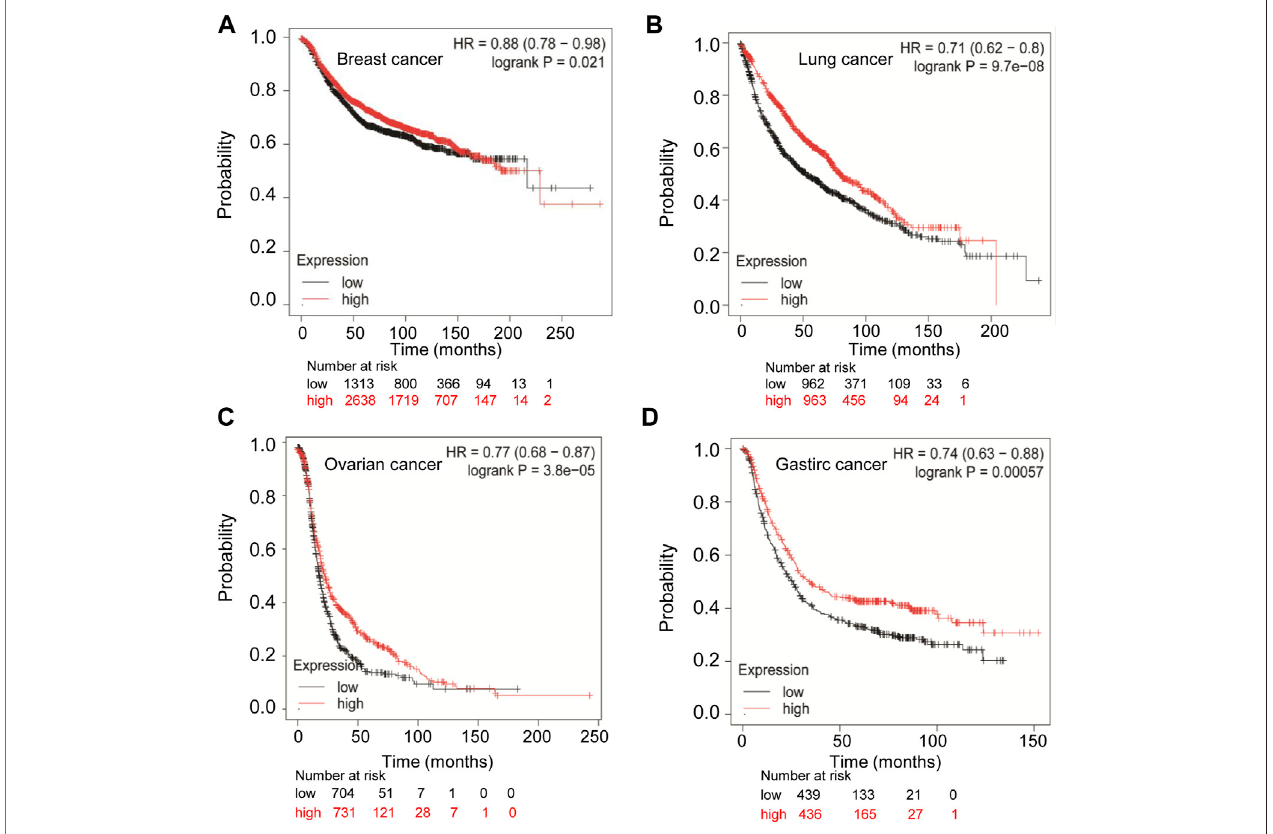
FIGURE2| ComparisonofKaplan-MeiersurvivalcurvesofhighlyexpressedandlowlyexpressedTMPRSS2indifferentcancers. (A) HighexpressionofTMPRSS2 in breast cancer ( n = 3951) had a poor prognosis analyzed by the Kaplan-Meier plotter database. High expression of TMPRSS2 had favorable prognosis in lung cancer ( n = 1925) (B) , ovarian cancer ( n = 1435) (C), and gastric cancer ( n = 875) (D) analyzed by Kaplan-Meier plotter